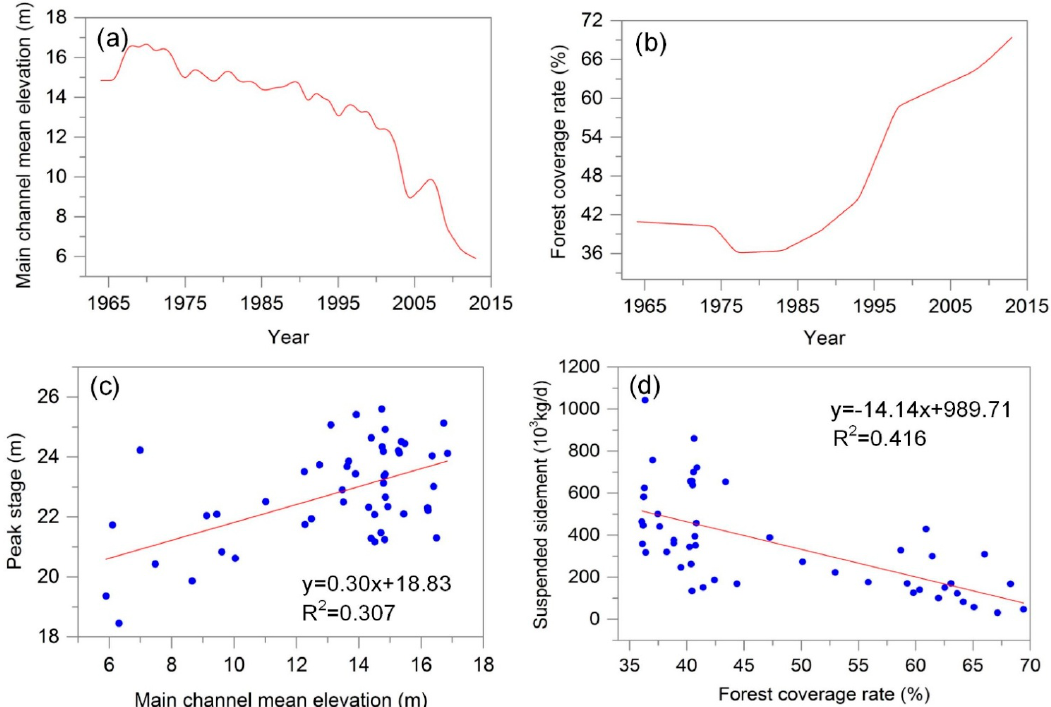
Figure 2. Data analyses of four variable series in the Ganjiang River basin (GRB) during 1964–2013. ( a ) is evolution of the main channel mean elevation ( MCE ) at Waizhou station, ( b ) is evolution of forest coverage rate ( FCR ) of the GRB, and two correlation plots are between peak water stage ( Z ) and MCE ( c ) and suspended sediment load ( S ) and FCR ( d ), respectively. R 2 value is the square of the correlation coefficient.